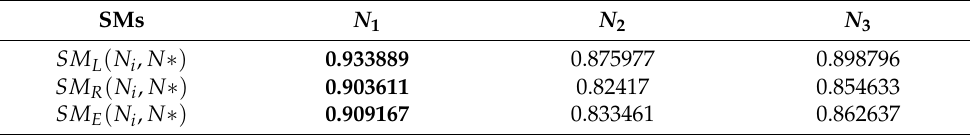
Table 4. Similarity measures between ideal alternative N ∗ and nominees N i ( i = 1,2,3 )